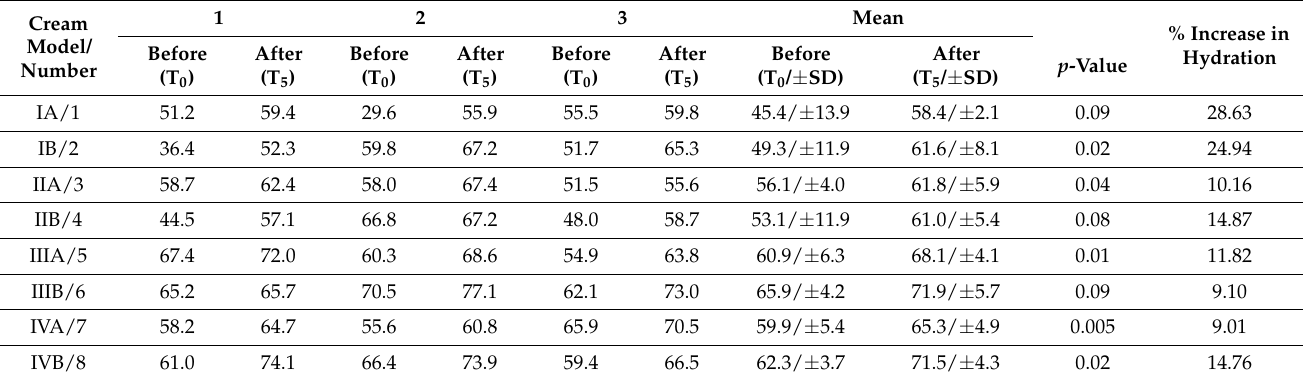
Table 3. Measurement values of skin hydration in percentage (%) before and after the measurements of skin hydration (T 0 vs. T 5) .